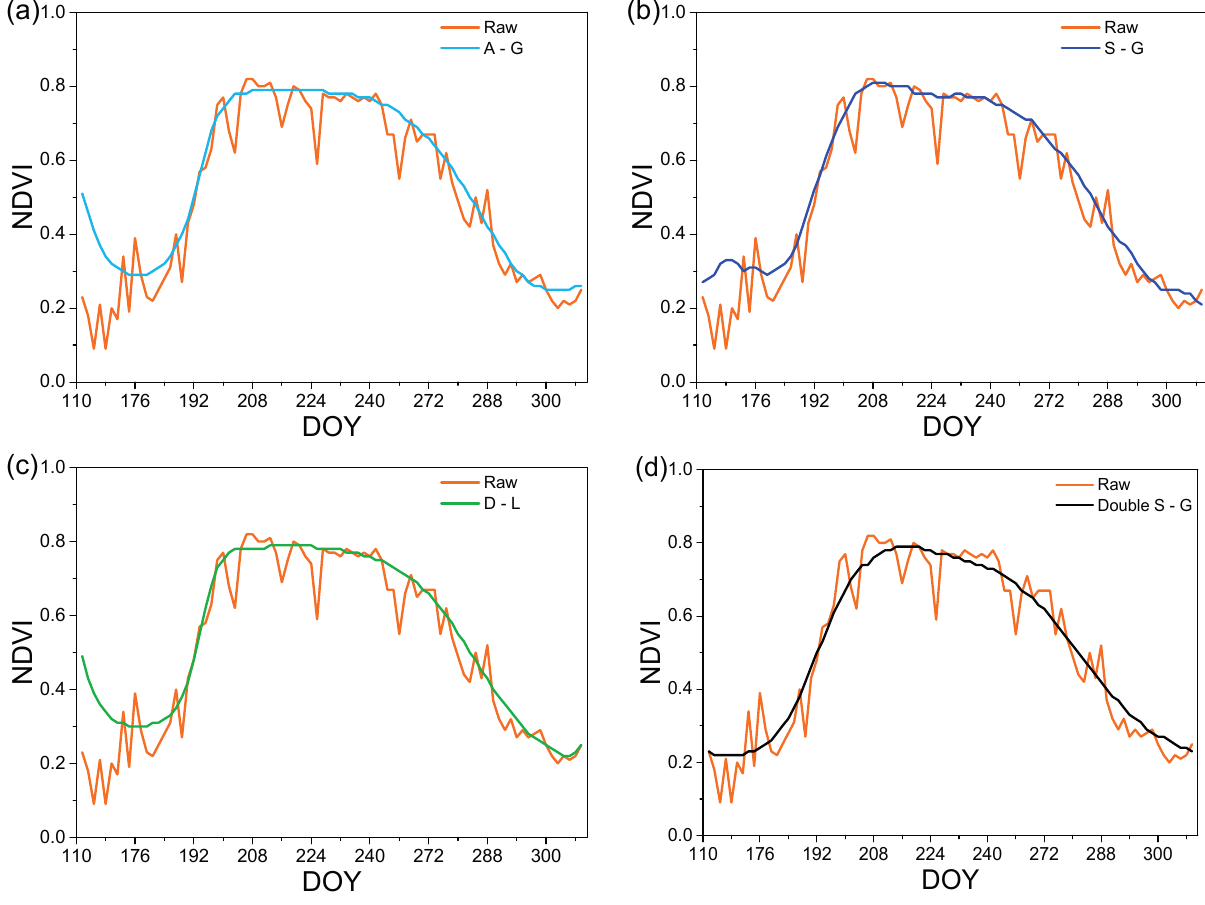
Figure 3. Removal of noise in time-series NDVI profile. ( a ) asymmetric Gaussian function; ( b ) Savitzky-Golay filtering; ( c ) double logistic functions; ( d ) Double Savitzky-Golay